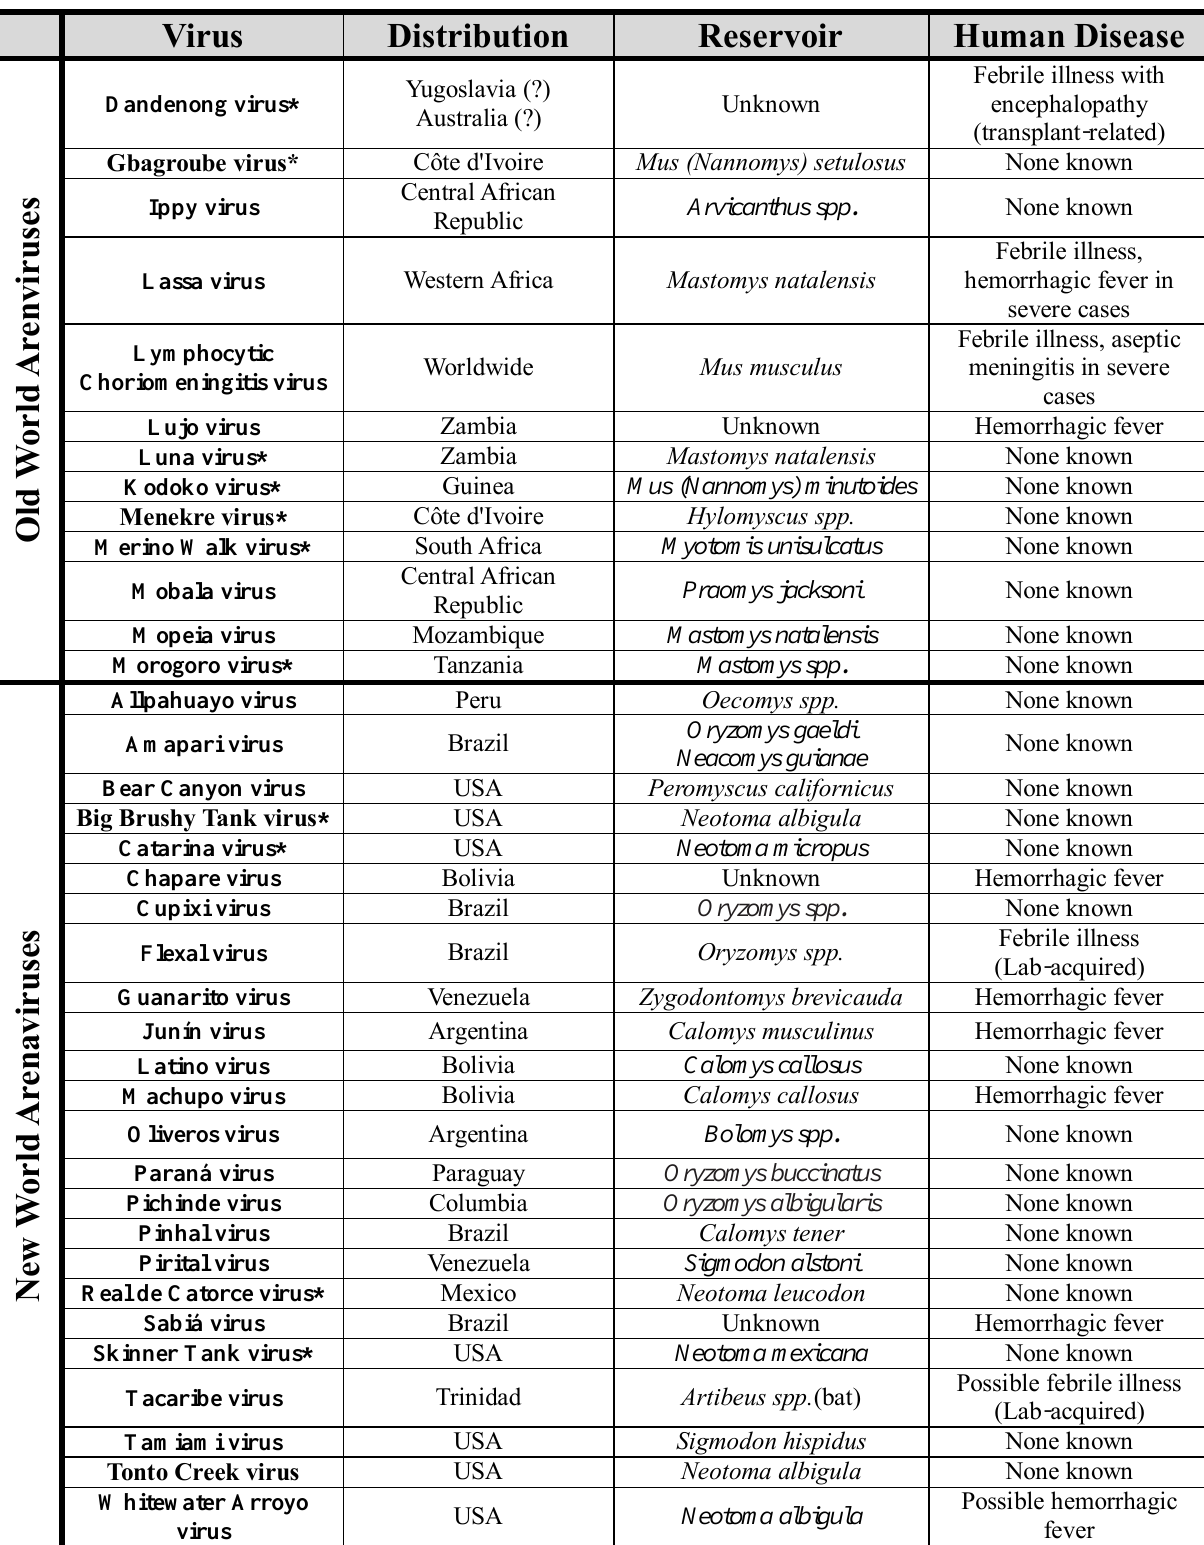
Table 1. Viruses of the family Arenaviridae , their geographic distribution, reservoirs and associated human